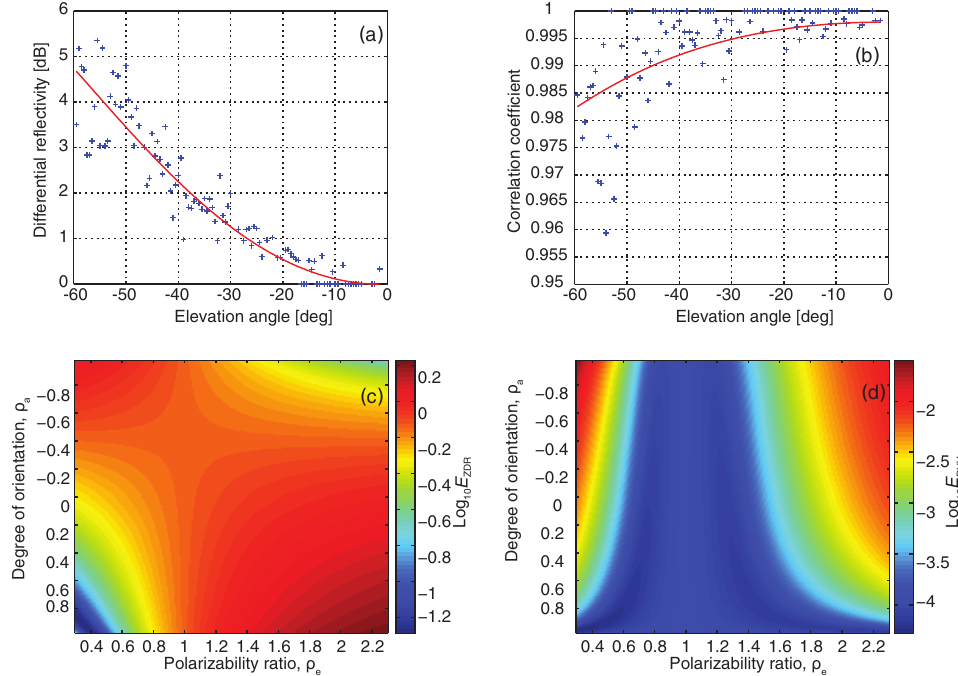
Figure 16. Measured (blue crosses) and approximated (red solid curve) elevation dependencies of differential reflectivity (a) and correlation coefficient (b) , and logarithms of E ZDR (c) and E RHV (d) . Measured data correspond to 4.7km height of the left half-scan of Fig. 14. According to the classification scheme described in the text, this case corresponds to a polarizability ratio of 0.4 (oblate